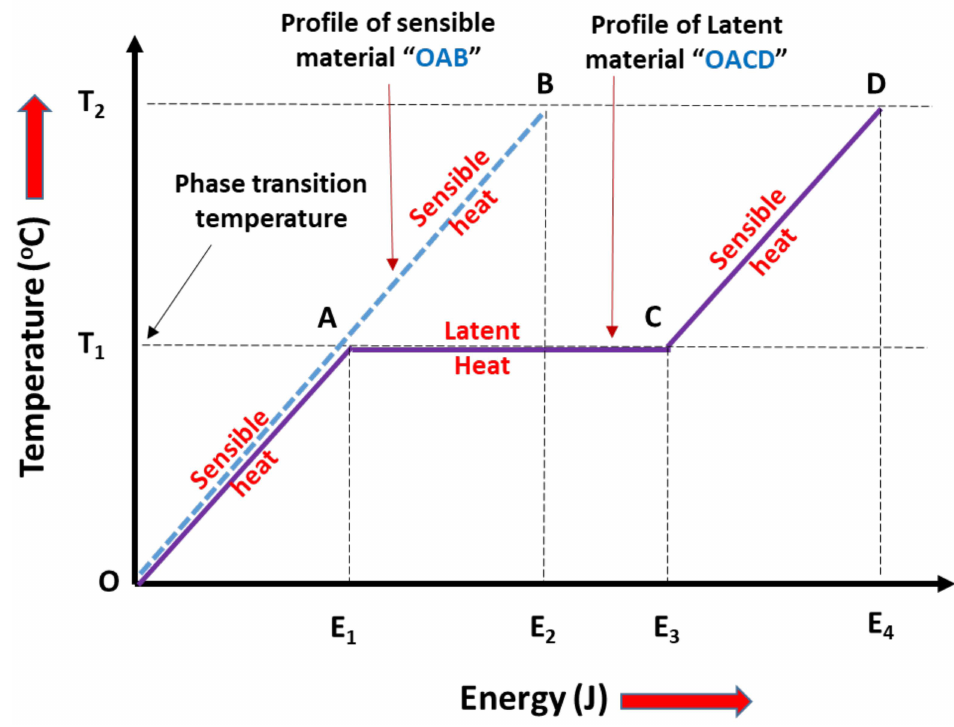
Figure 4. Temperature vs. energy profile of sensible and phase change material (latent).